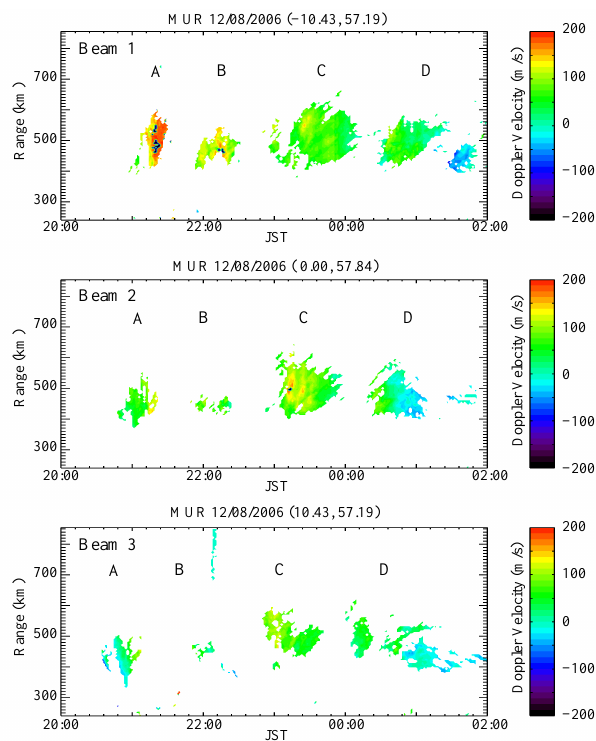
Fig. 5. Same as Fig. 4, except the Doppler velocity is shown.